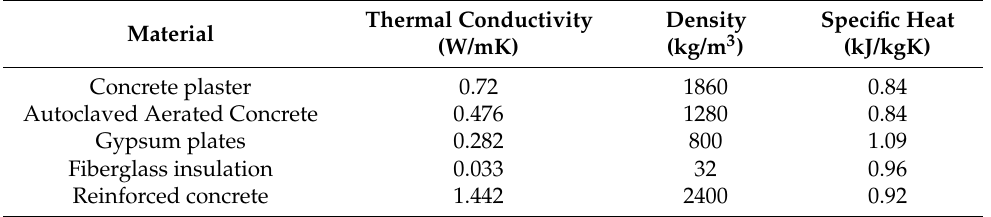
Table 6. Thermal properties of opaque materials employed in the envelope of the case-study building.